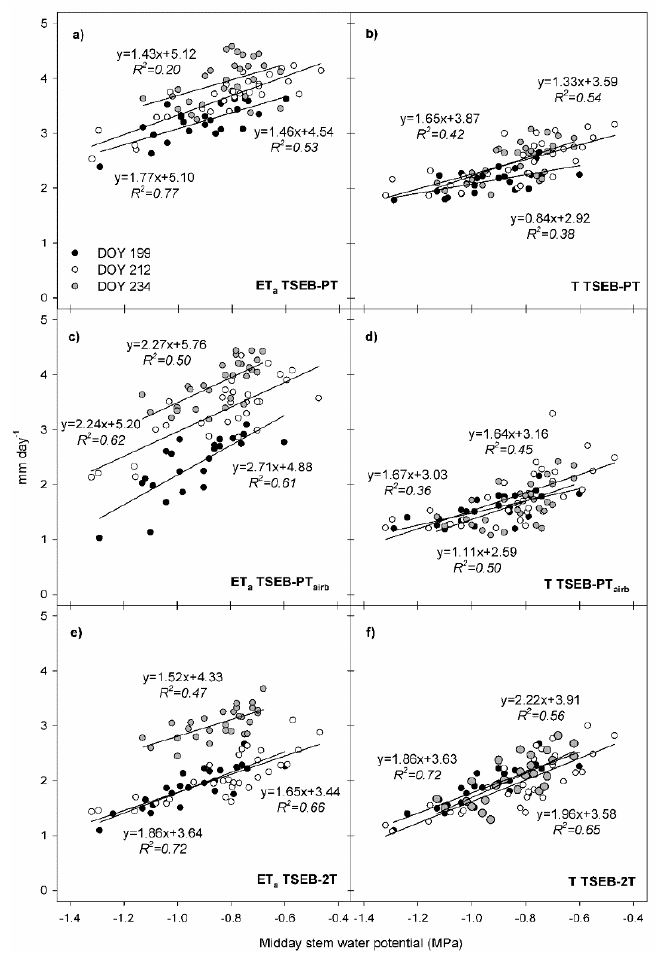
Figure 5. Scatterplots of the regression between midday stem water potential and actual (ET a ) and transpiration (T) for three dates: 18 July (DOY 199), 31 July (DOY 212) and 22 August (DOY 234), using the ( a , b ) TSEB-PT S2 + 3 , ( c , d ) TSEB-PT airb and ( e , f ) TSEB-2T methodologies. Validation was conducted with pixels containing the 32 measured